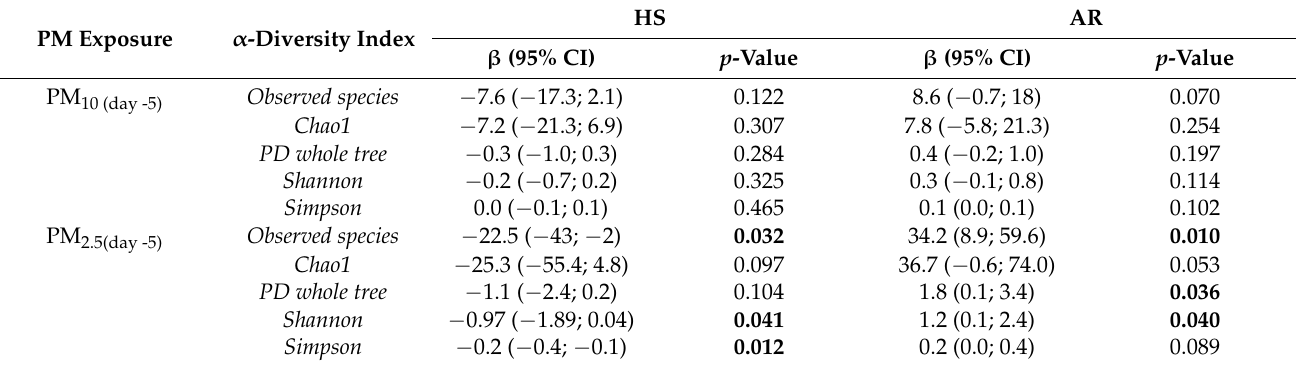
Table 6. Association between PM exposure (day -5) and α -diversity indices.